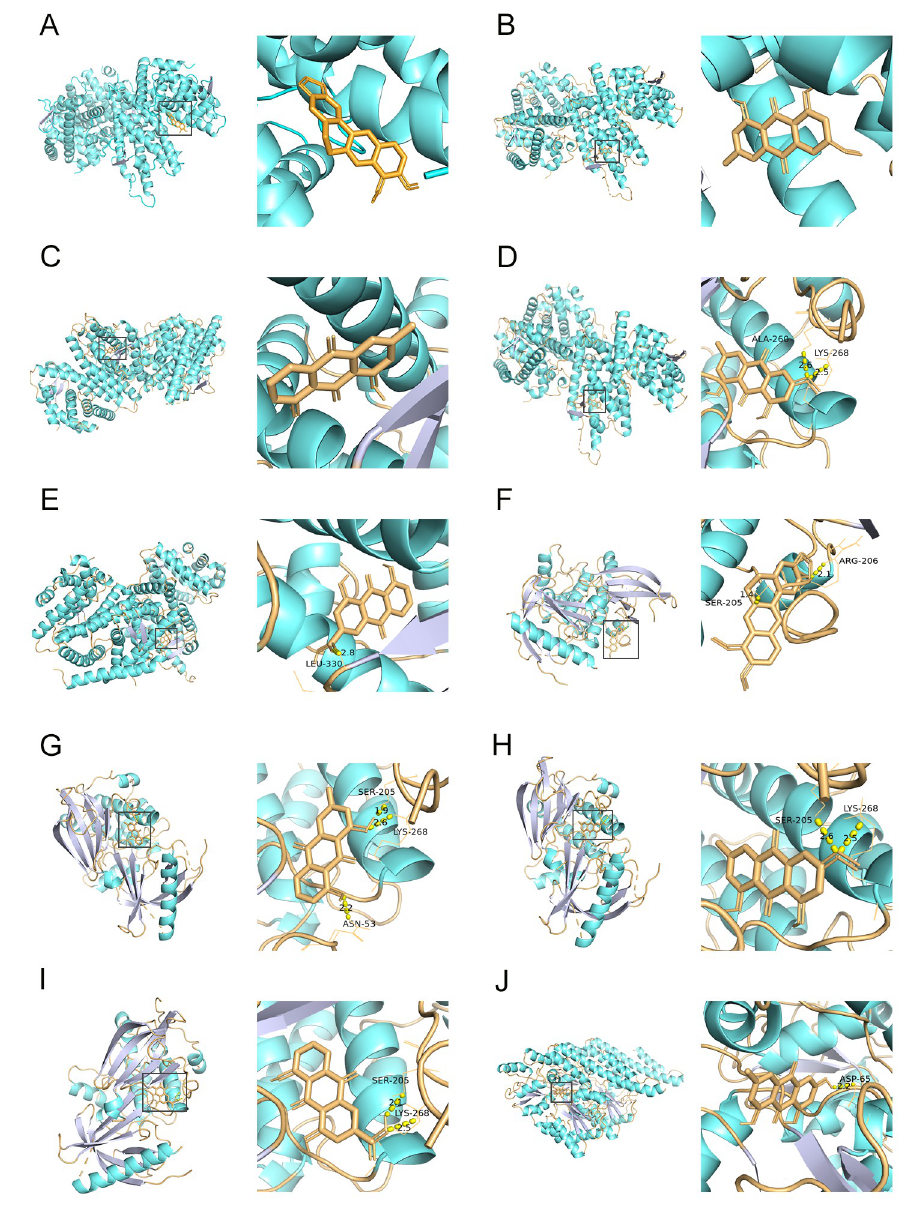
Fig 6. Molecular docking of SHCZF compounds and hub target proteins. (A-E) The binding mode of APOE and berberine chloride, physcion, chrysophanol, emodin, and rhein, respectively. (F-I) The binding mode of AKT1 and berberine chloride, chrysophanol, physcion, and rhein, respectively. (J) The binding mode of TP53 and